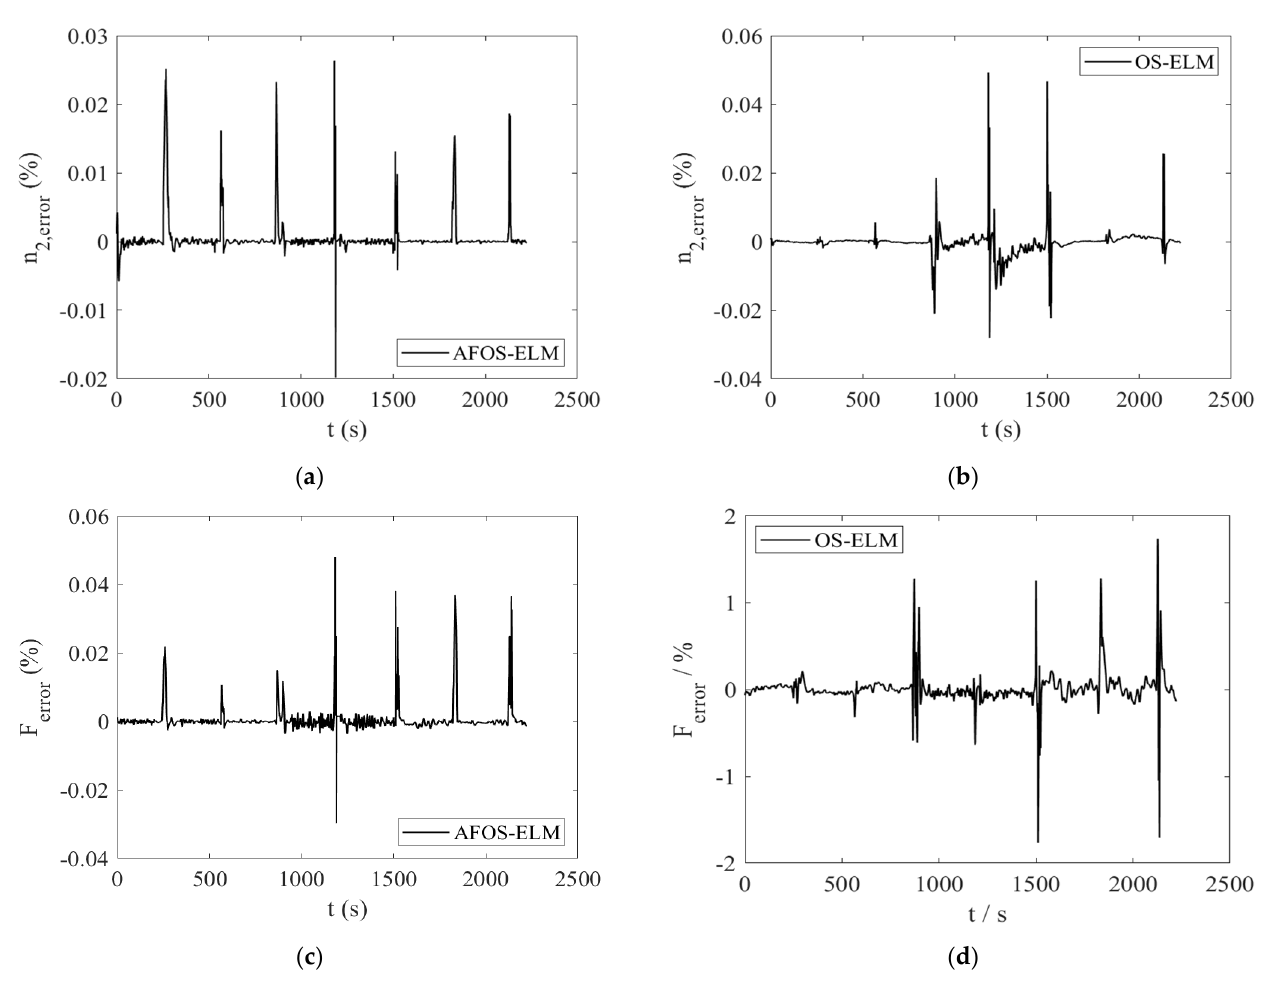
Figure 3. Comparison of neural network n 2 ( k + 1) output. ( a ) AFOS-ELM n 2 ( k + 1) output; ( b ) OS- ELM n 2 ( k + 1) output.